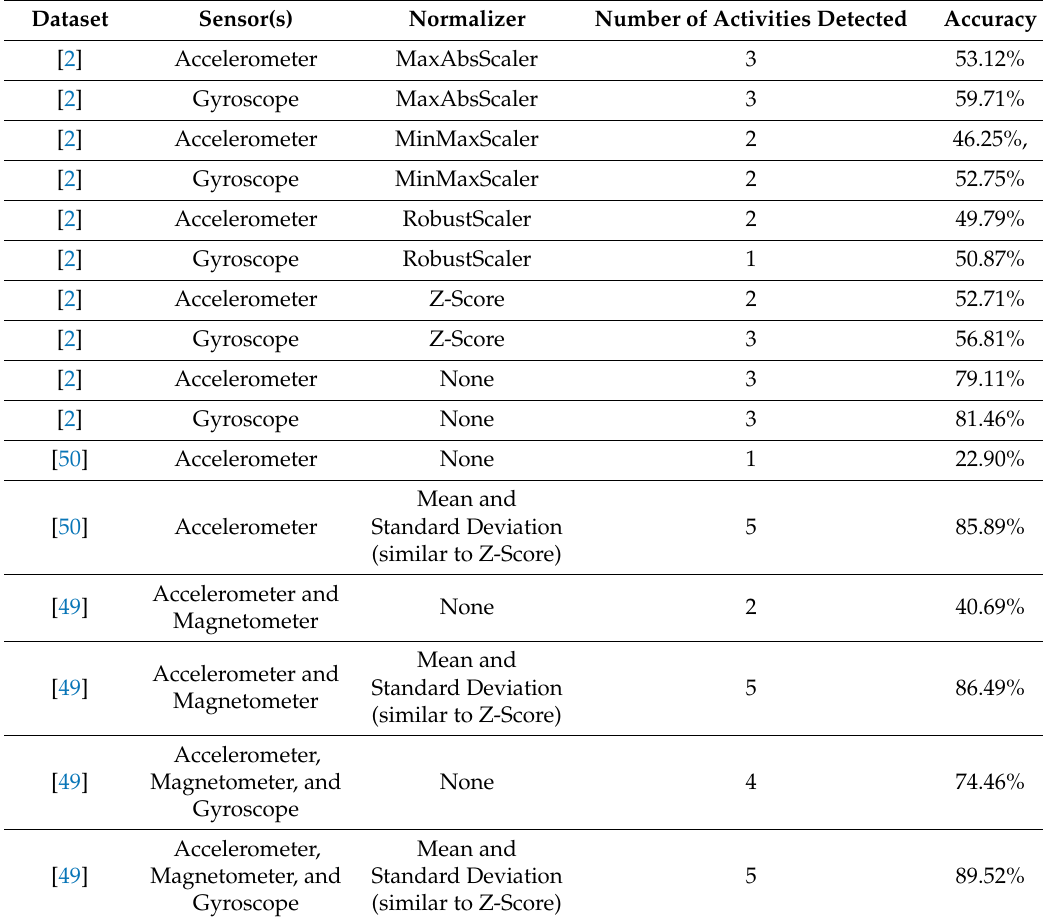
Table 11. Comparison of results obtained with a previous